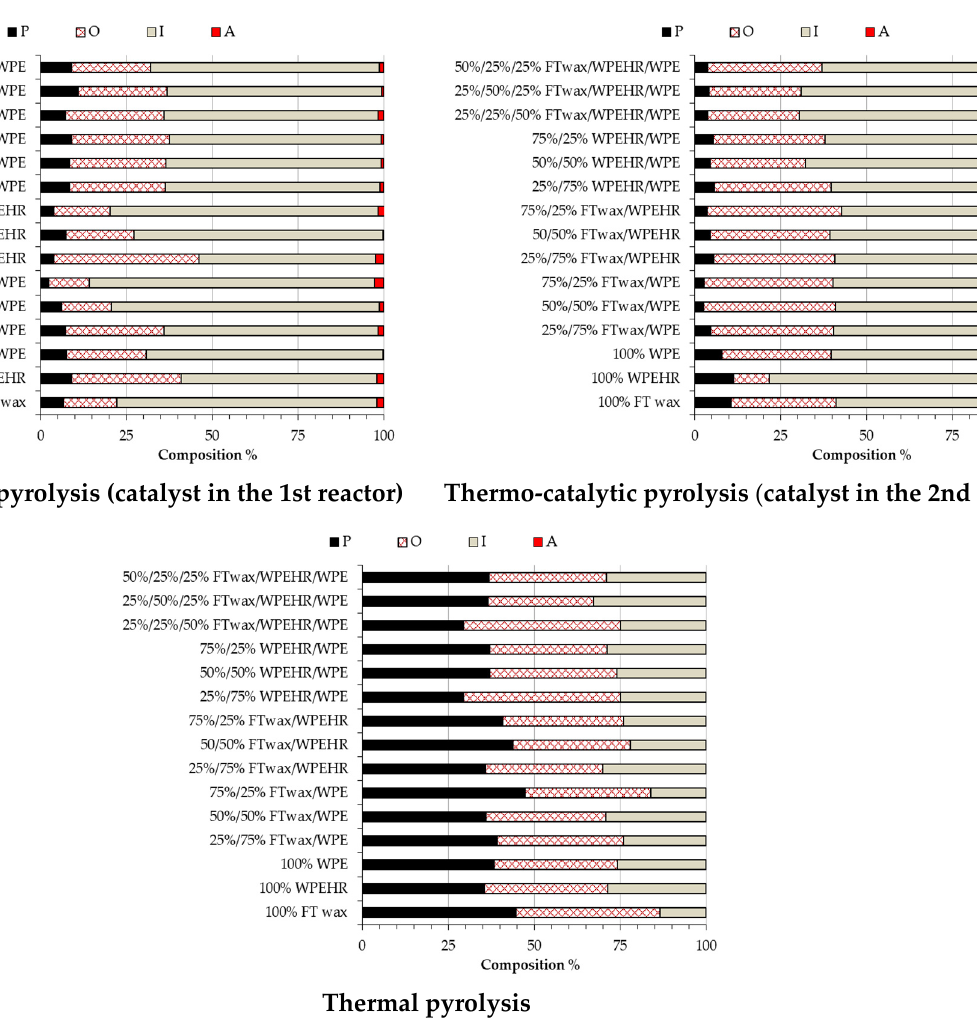
Figure 5. Hydrocarbon group composition of pyrolysis liquid products (P: n-paraffins, O: n-olefins, I: isomers, A: aromatics).